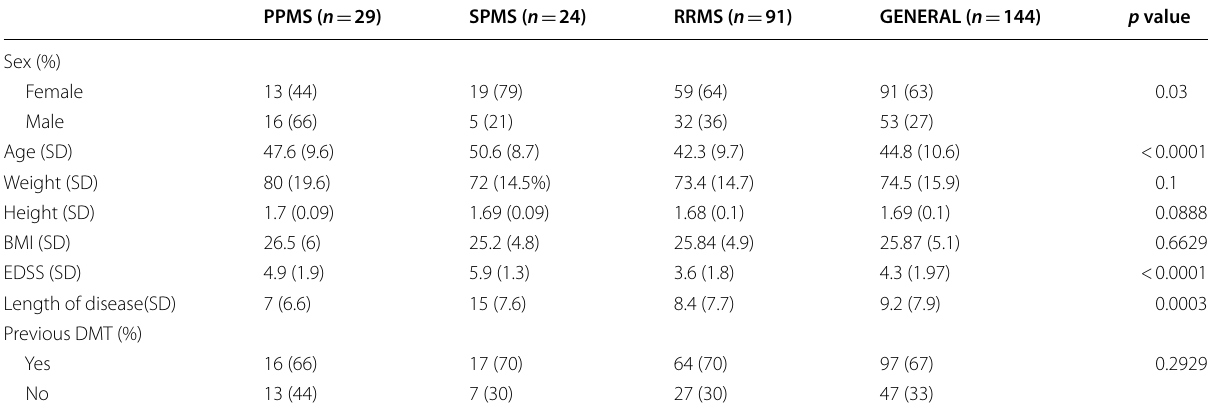
Table 1 Demographic and clinical features in pwMS involved in the study